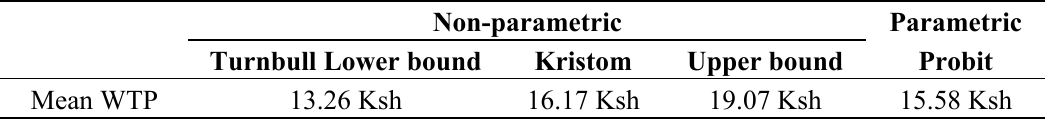
Table 2. Non-parametric and parametric estimates of average willingness to pay (WTP) in Kenyan Shillings